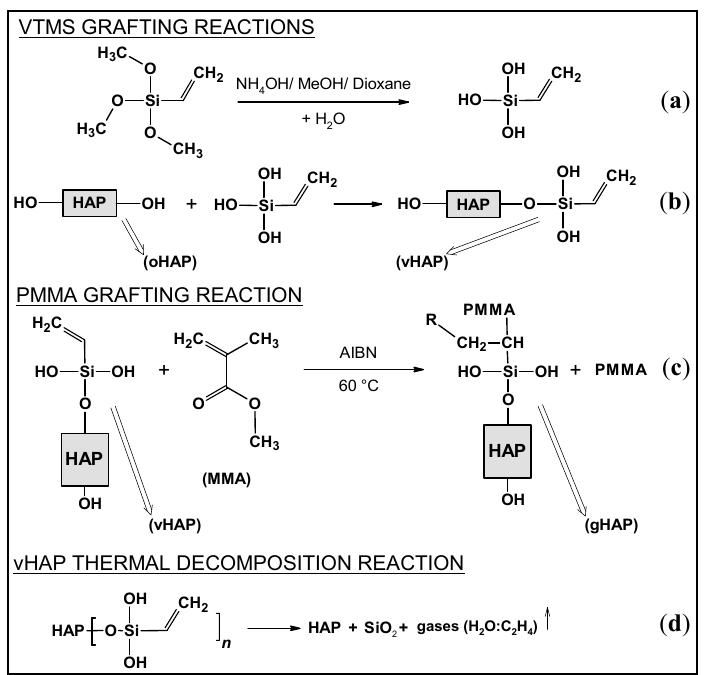
Figure 1. FTIR spectra of ( a ): oHAP, ( b ): vHAP, ( c ): gHAP and ( d ): VTMS.